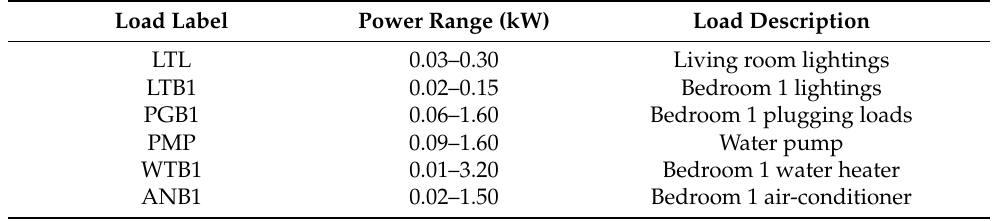
Table 1. Load label under experiments.